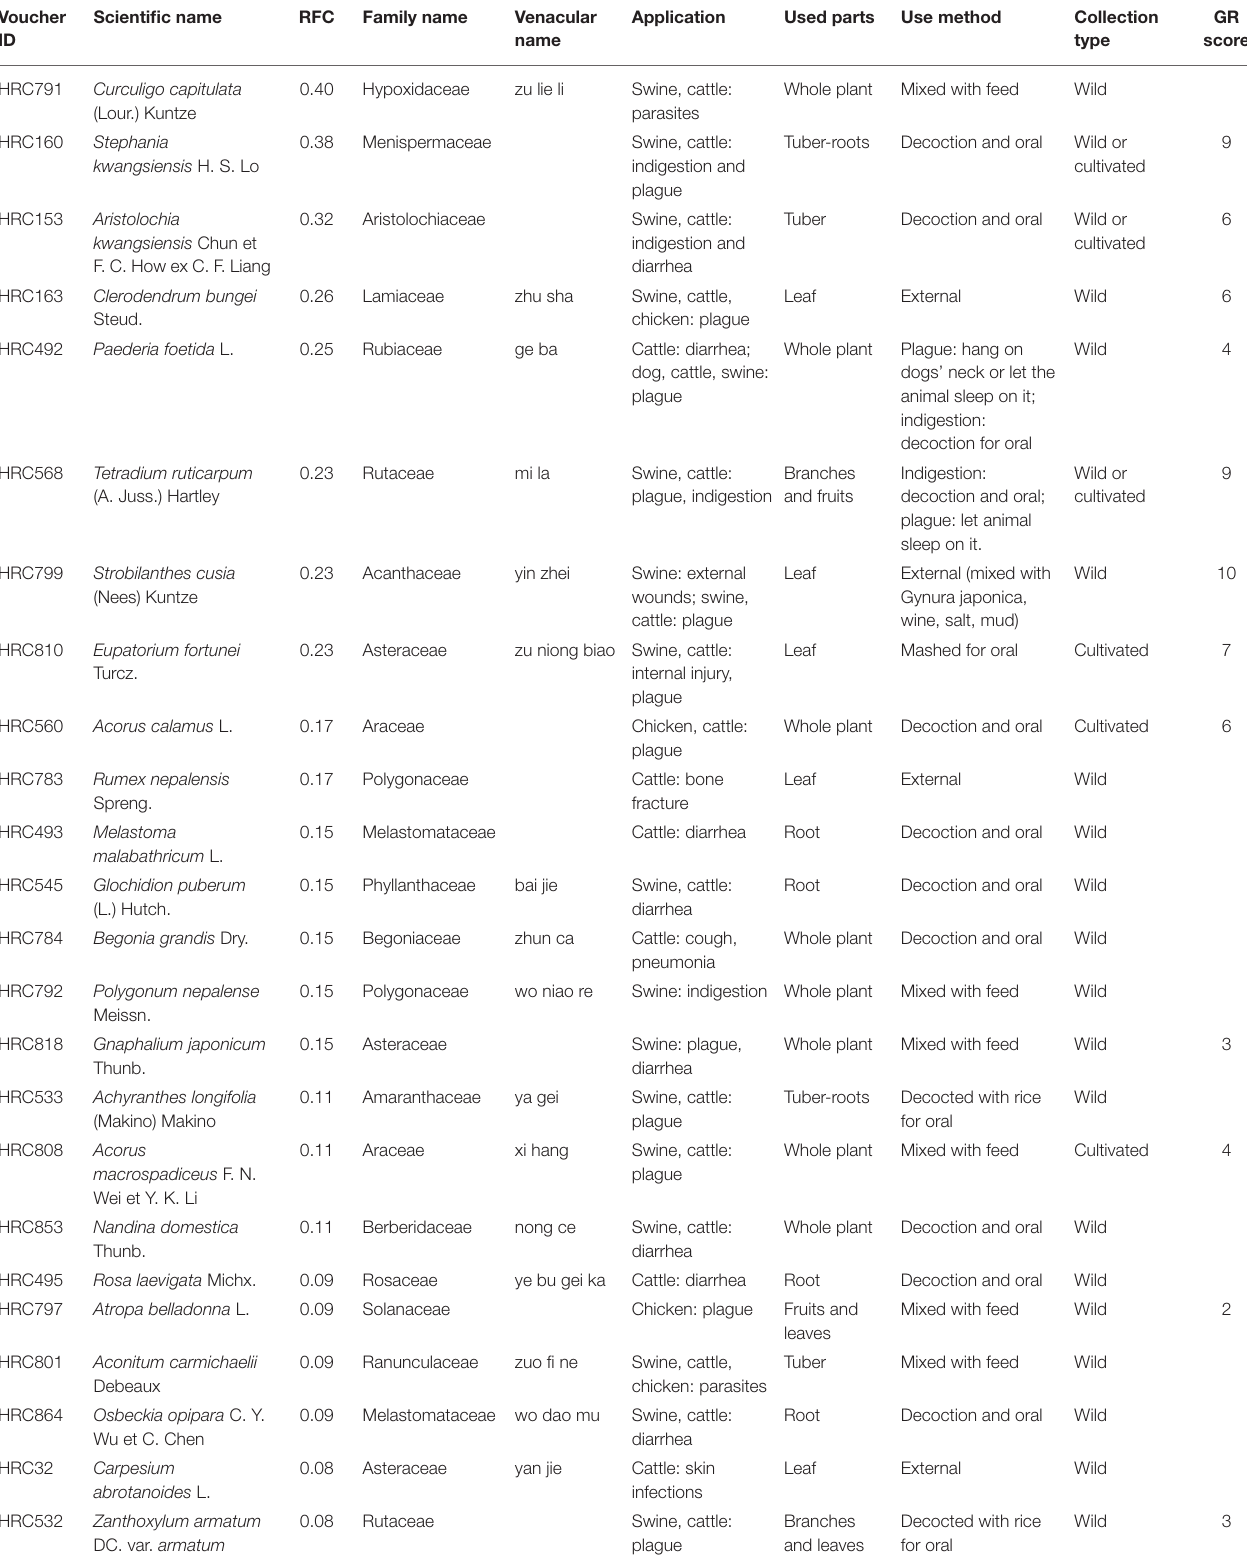
TABLE 2 | Ethnobotanical inventory of the ethnoveterinary plants used by the Baiku Yao people. Voucher